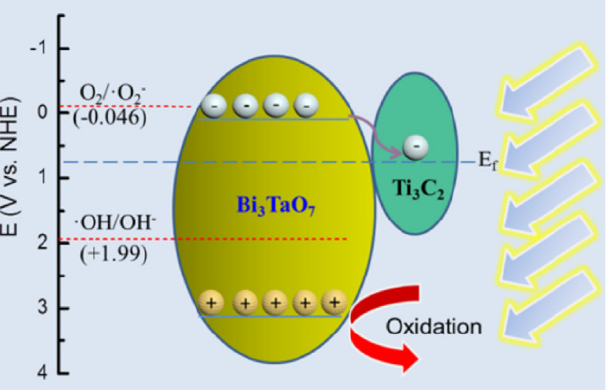
Figure 5. The proposed mechanism for MB removal with BTC-10 under visible light irradiation [107].